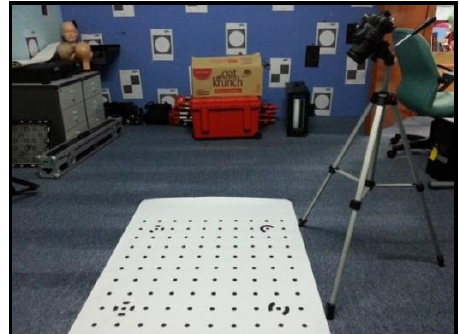
Figure 2. Photogrammetric camera self-calibration using Photomodeler V5.0